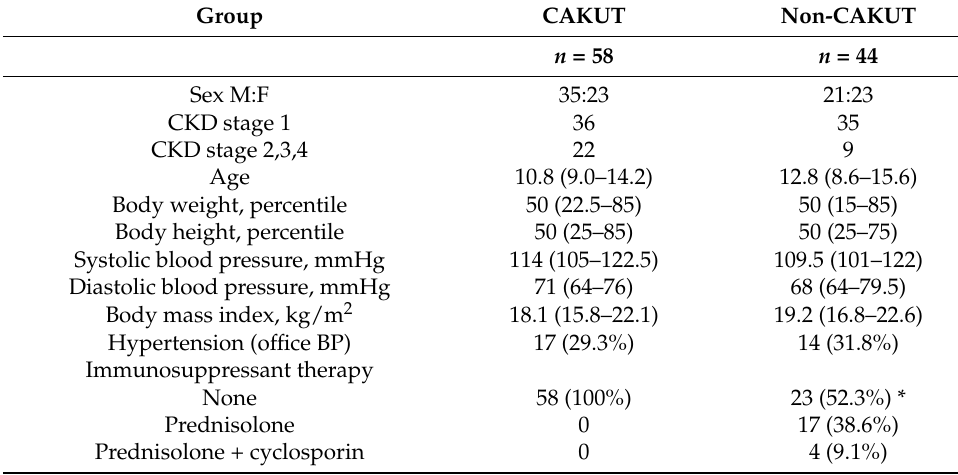
Table 1. Clinical, anthropometric, and biomedical characteristics in children with